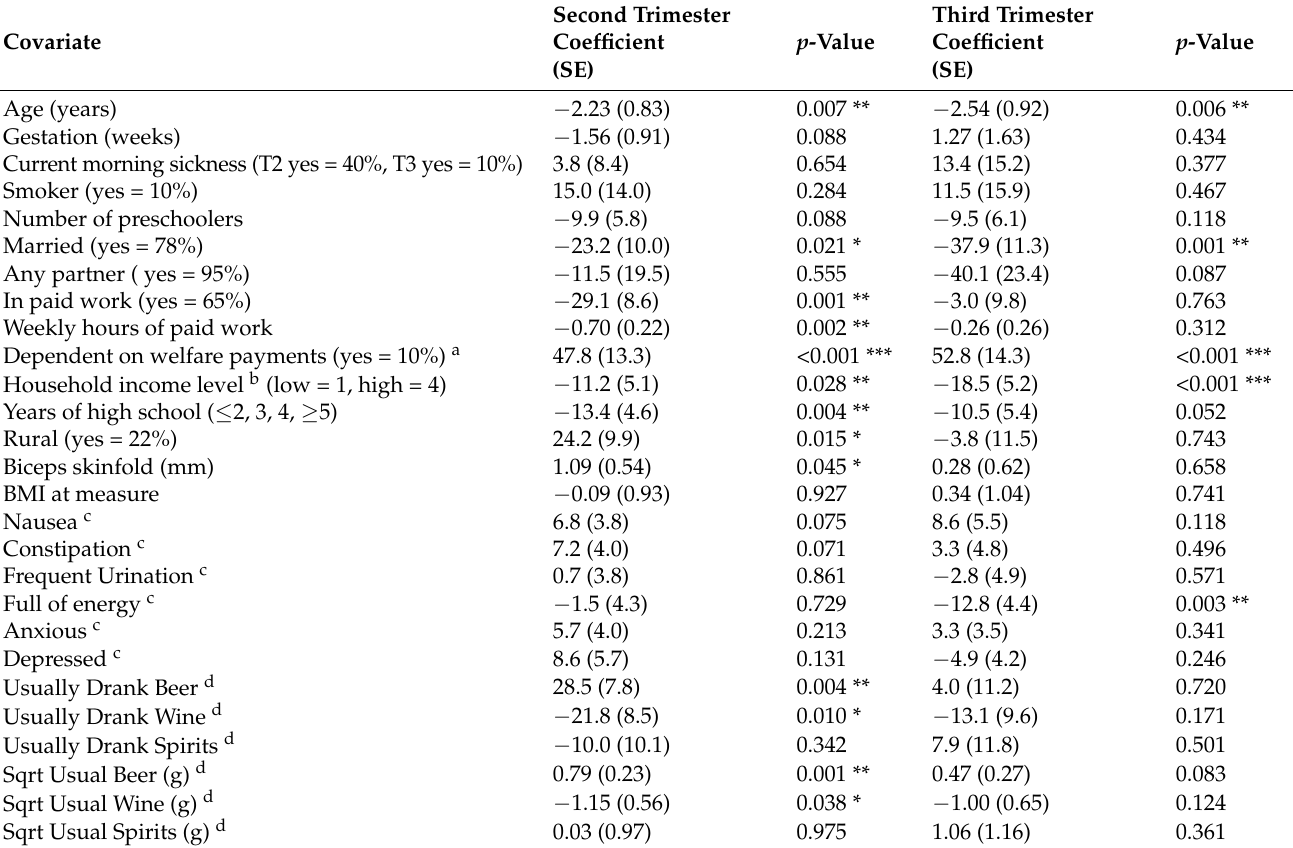
Table 1. Demographic and non-dietary predictors of minutes of TIB per day in the second and third